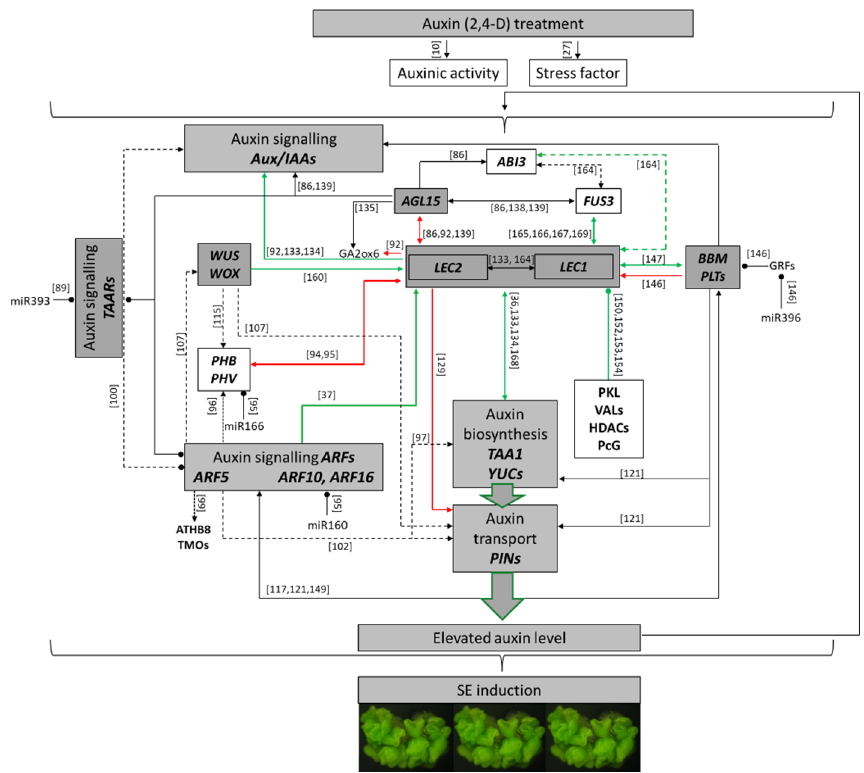
Figure 1. An overview of the regulatory interactions that control SE induction. Treating explants with auxin (mostly 2,4-D) activates a number of the TF genes that have a regulatory function in embryonic development, including the LEC1 and LEC2 of the LAFL group, BBM ( PLTs ), AGL15 and WUS / WOX genes. The down-stream targets include the genes of the TAA1 / YUC of the auxin biosynthesis pathway, the PINs that control auxin transport and the core regulators of auxin signalling (AUX / IAAs and ARFs). Other regulatory elements of the SE-network also involve miRNAs and the epigenetic regulators (PKL, VALs, HDACs). The arrows and circle-shaped ends indicate the activation or repression of gene expression, respectively. The solid and dashed lines indicate the experimentally validated and suggested regulatory interactions, respectively. The red and green lines indicate the regulatory interaction between LEC2 and LECs, respectively [164–169].